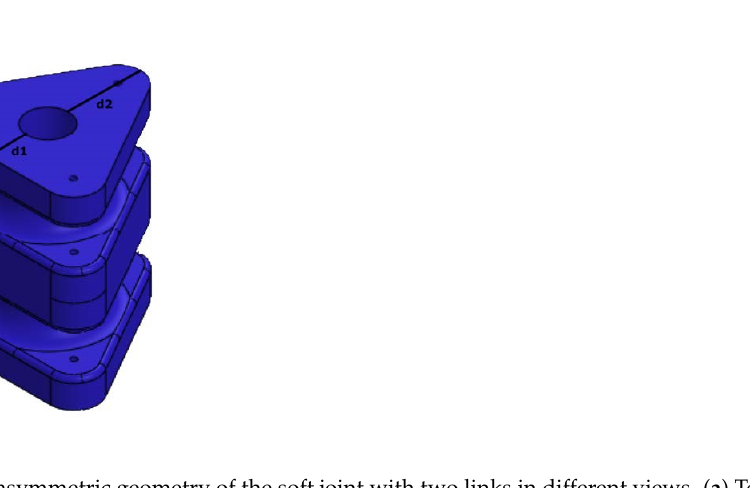
Figure 1. Triangular asymmetric geometry of the soft joint with two links in different views. ( a ) Top view showing the 120 ◦ angle relationship between the different tendon routing points. ( b ) Front view. ( c ) Perspective view, showing d1 and d2 distances defining asymmetry and holes for routing tendons.